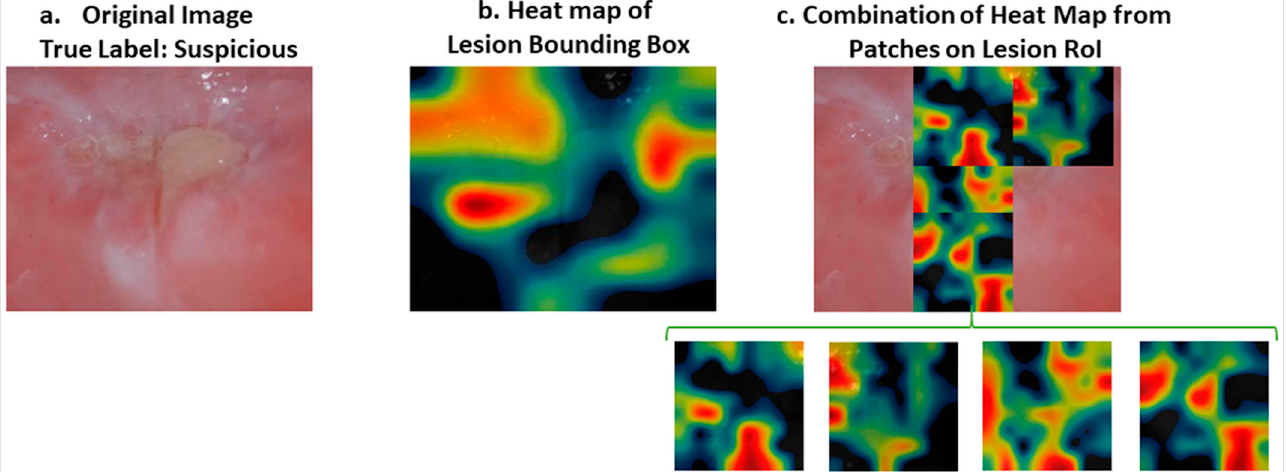
Figure 7. ( a ) Original image. ( b ) Heat map of lesion bounding box. ( c ) Heat map of a combination of patches belonging to the severe part of the lesion area. Original image was classified as “suspicious” when the region of interest was tested. However, the heat map of the region of interest did not reflect the severe part of the image with a warm color (e.g., red). On the other hand, when we divide the severe part of the image into four patches, the heat map of the patches indicates the severe region with an intense color between yellow and red. RoI: Region of Interest